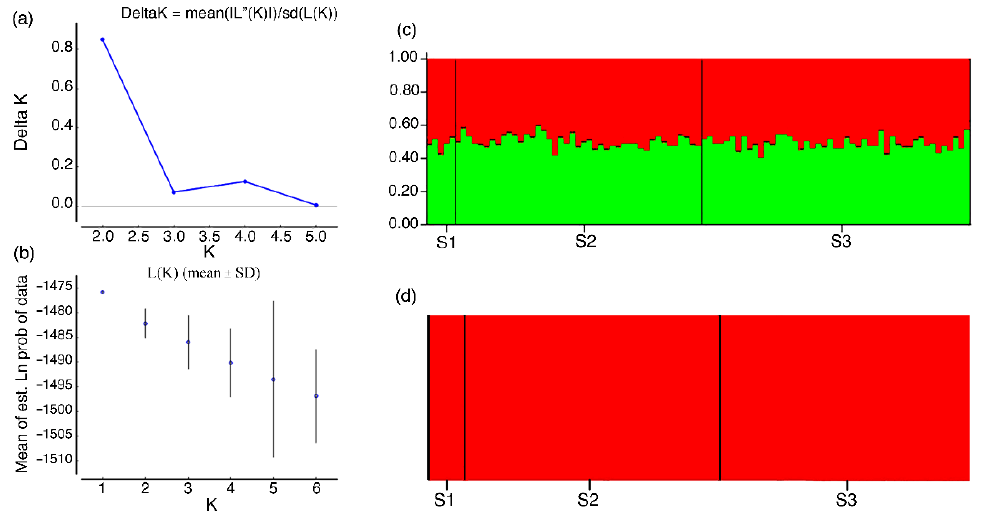
Figure 4. Estimate of the probable groups of populations produced by the STRUCTURE ( a – c ) and BAPS ( d ), between 95 samples of Steindachneridion melanodermatum from the Lower Iguaçu River. ( a ) Values of K obtained based on ΔK. ( b ) K obtained based on mean likelihood Ln (K). ( c ) Graphic representation of K = 2. ( d ) Graphic representation of K = 1.